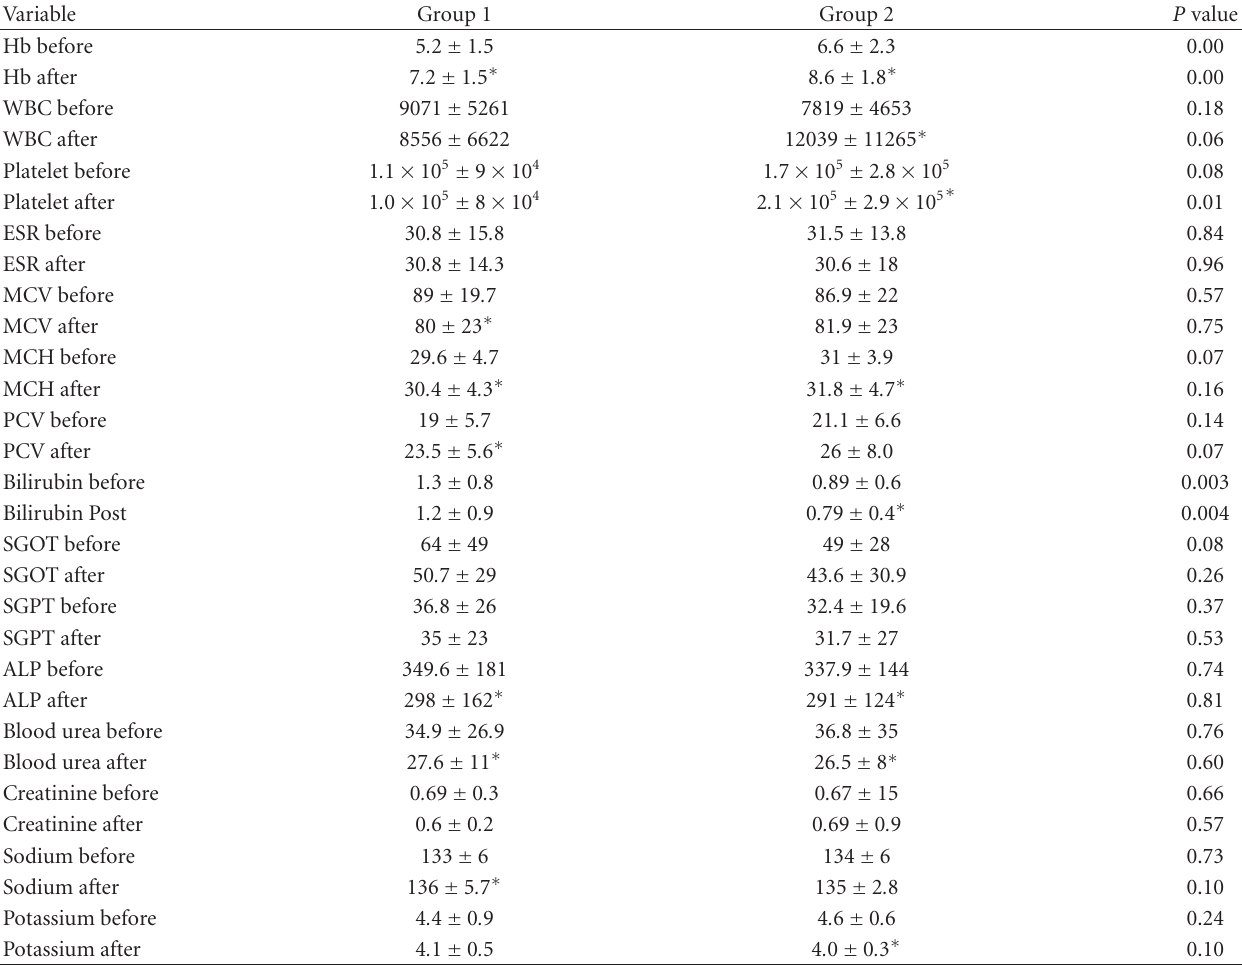
Table 3: Clinical parameters of baseline complete blood count (CBC), liver and kidney function profile.